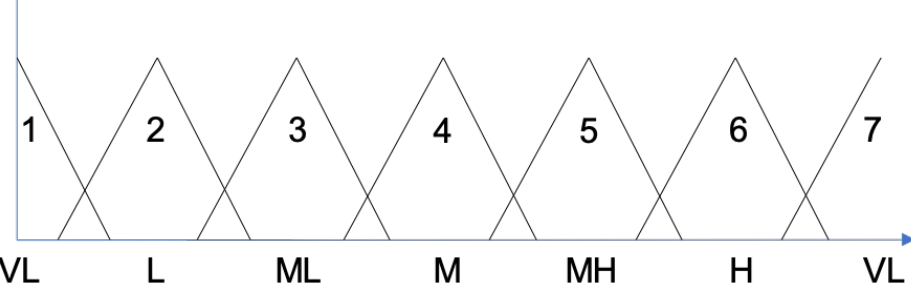
Figure 3. The fuzzy partition adopted in the